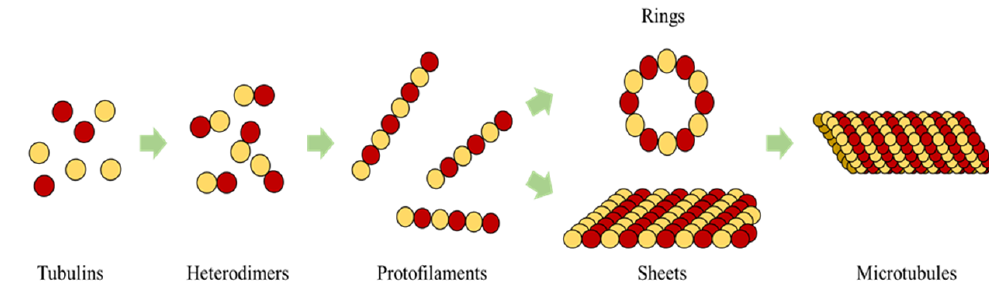
Figure 1. Self-organization of Tubulins, Heterodimers, Protofilaments, Sheets, Rings, intermittent structures leading to Microtubule